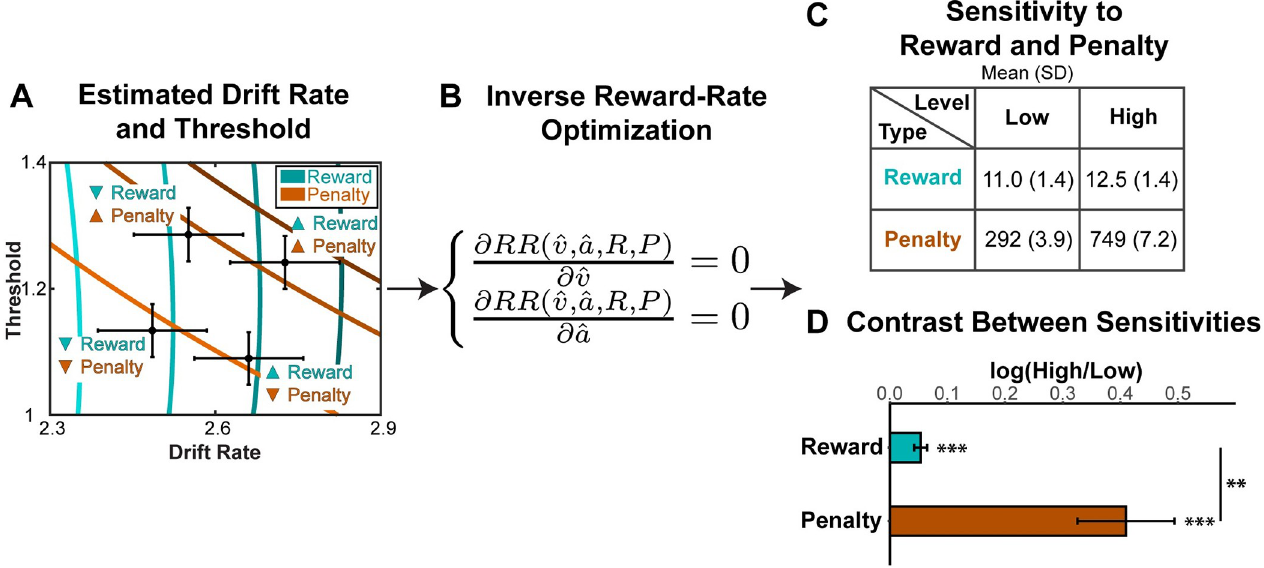
Fig 5. Inference of reward and penalty sensitivity based on DDM estimates and reward rate optimization model. (A) Estimated group-level reward-rate- optimal combinations of drift rate and threshold for the four conditions in the experiment (reproduced from Fig 4C). (B) To infer the sensitivity to reward and penalty for a given individual, we invert this reward rate optimization procedure, estimating the set of reward and penalty weights ( R and P ) that best accounts for that person’s pattern of behavior in a given condition. (C-D) The resulting estimates of sensitivity to reward and penalty recapitulate our experimental manipulation, with higher sensitivity to reward in the high vs. low reward condition, and higher sensitivity to penalty for the high vs. low penalty condition. (C) Summary statistics across individual participants. (D) Summary of individual-level contrasts between sensitivity to high vs. low reward and penalty. Error bars reflect s.e.m. �� : p < 0.01; ��� : p < 0.001. Parameter recovery validates subjective weight estimates (see Part 5 in S1 Supporting Information).